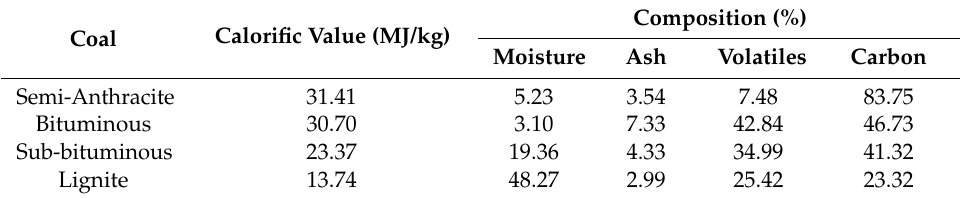
Table 10. Physical composition of Indonesian coal by type.